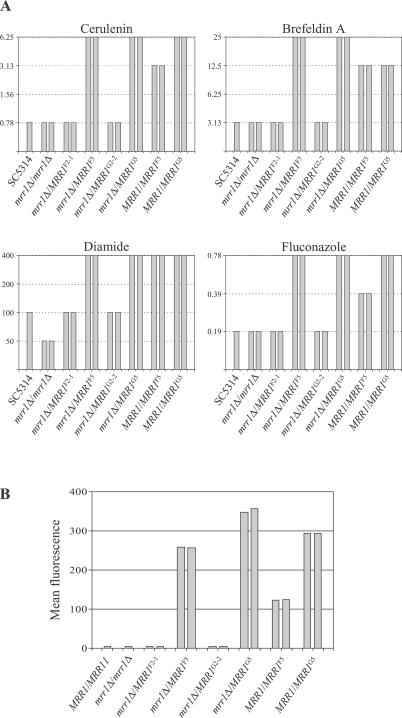

MRR1 Gain-of-Function Alleles Cause Constitutive MDR1 Overexpression and Multidrug Resistance(A) MICs (in μg ml−1) of the indicated metabolic inhibitors for the wild-type parental strain SC5314, two independently constructed homozygous mrr1Δ mutants, and derivatives carrying the indicated mutant MRR1 alleles in the absence or presence of a wild-type MRR1 allele.(B) MDR1 promoter activity in a wild-type reporter strain, an mrr1Δ mutant, and derivatives carrying the indicated mutant MRR1 alleles in the absence or presence of a wild-type MRR1 allele. The strains were grown to log phase in YPD medium and the mean fluorescence of the cells was determined by flow cytometry.